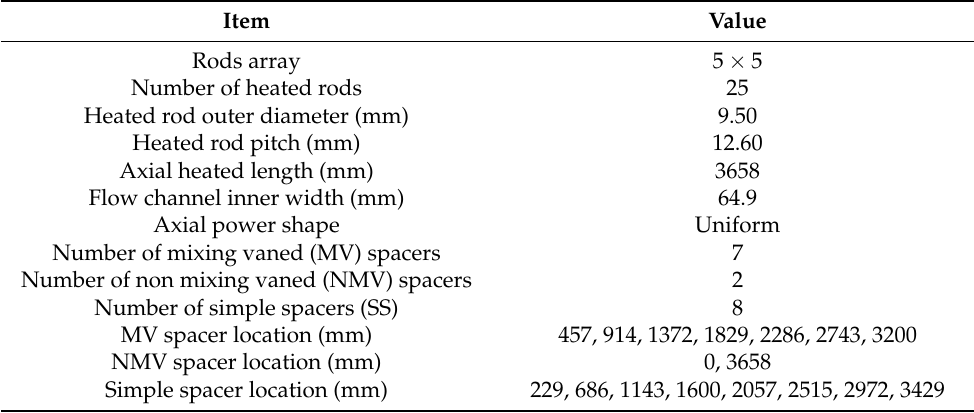
Table 1. 5 × 5 PSBT rod bundle